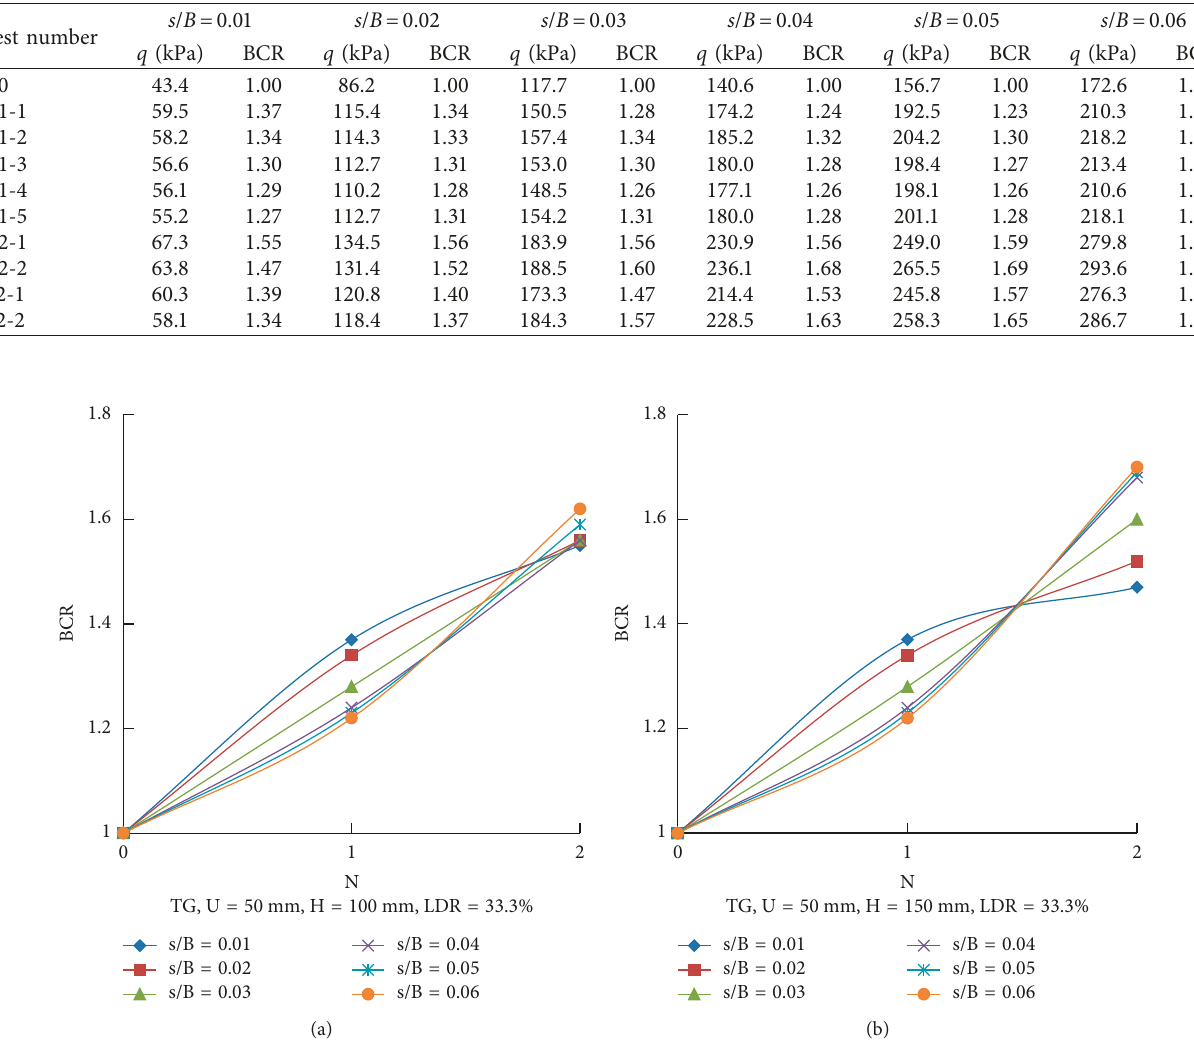
Figure 8: The relationship between BCR and N : (a) TG, U LDR (cid:30)